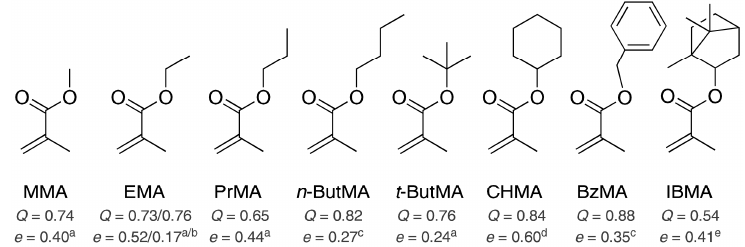
Figure 1. (Co)-monomers with the corresponding Q , e -values taken from a [33], b [34], c [35], d [36], and e